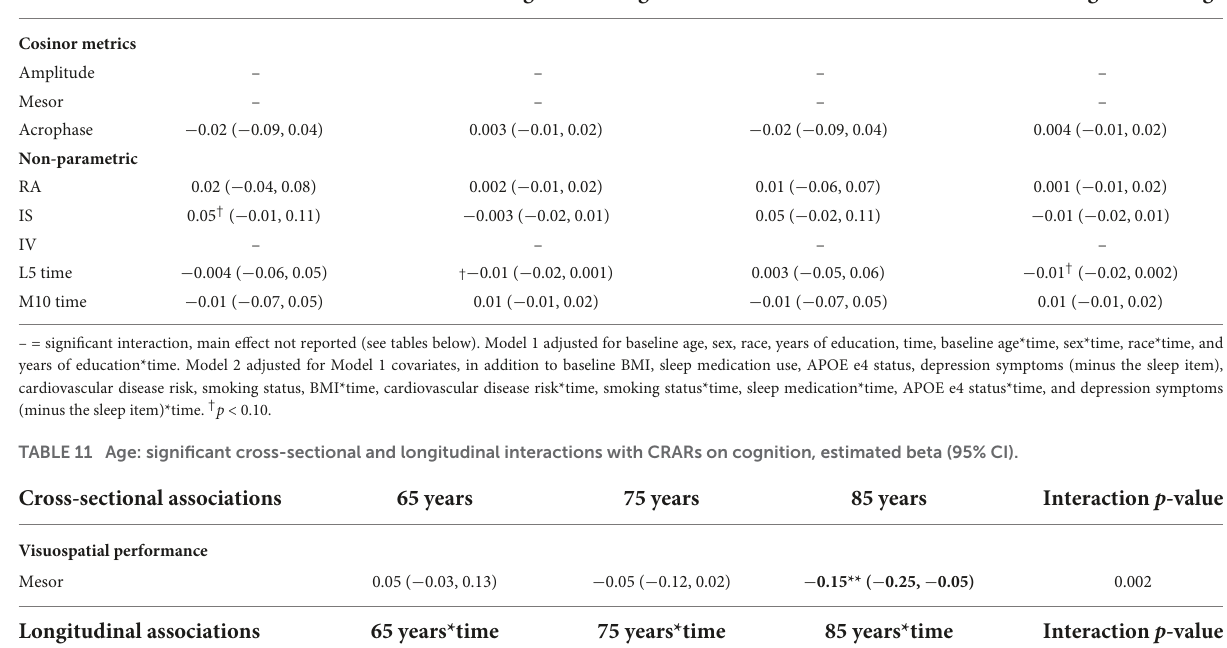
TABLE 10 Associations of circadian metrics with attention, estimated beta (95% CI).